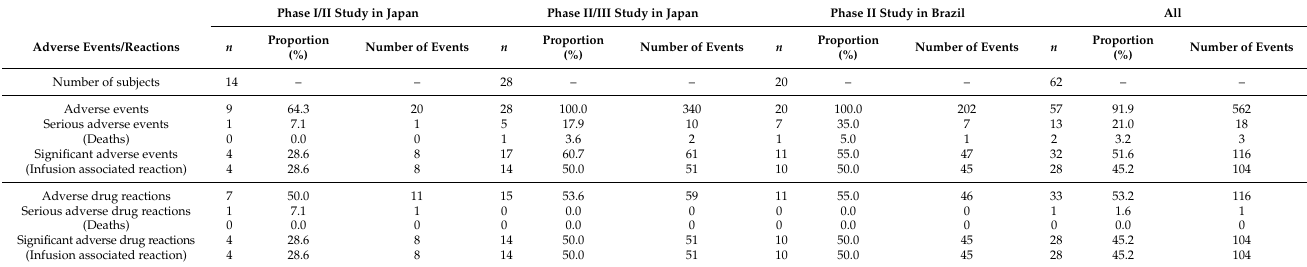
Table 3. Summary of adverse events and adverse drug reactions for pabinafusp alfa in the phase II/III and II studies (updated from